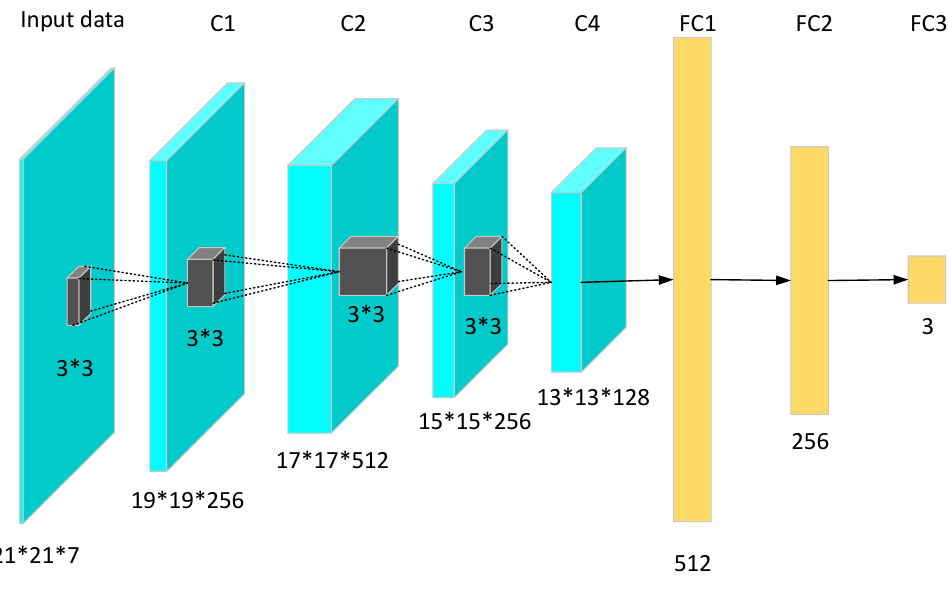
Figure 5. CNN model architecture with 4 convolutional